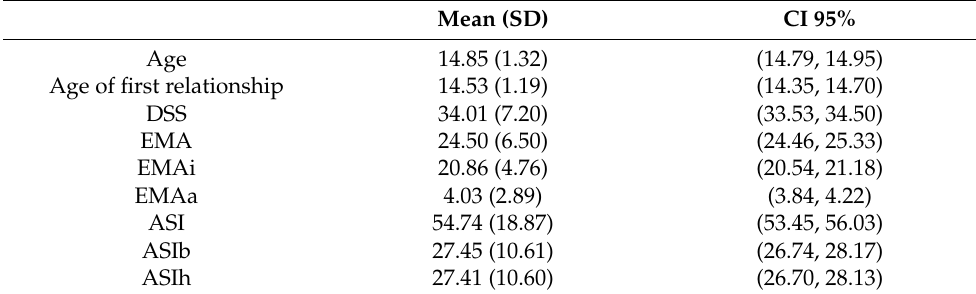
Table 2. Descriptive analysis of quantitative variables.